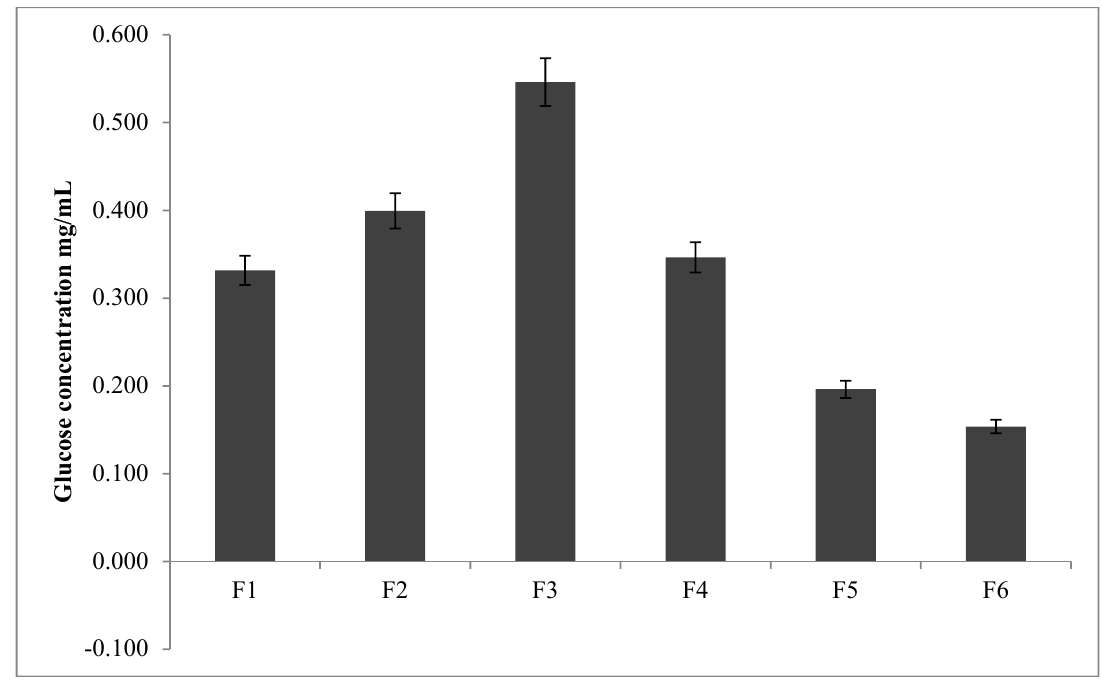
Figure 3. Concentration of glucose adsorbed onto conjugates as a function of boronic acid content ( n =